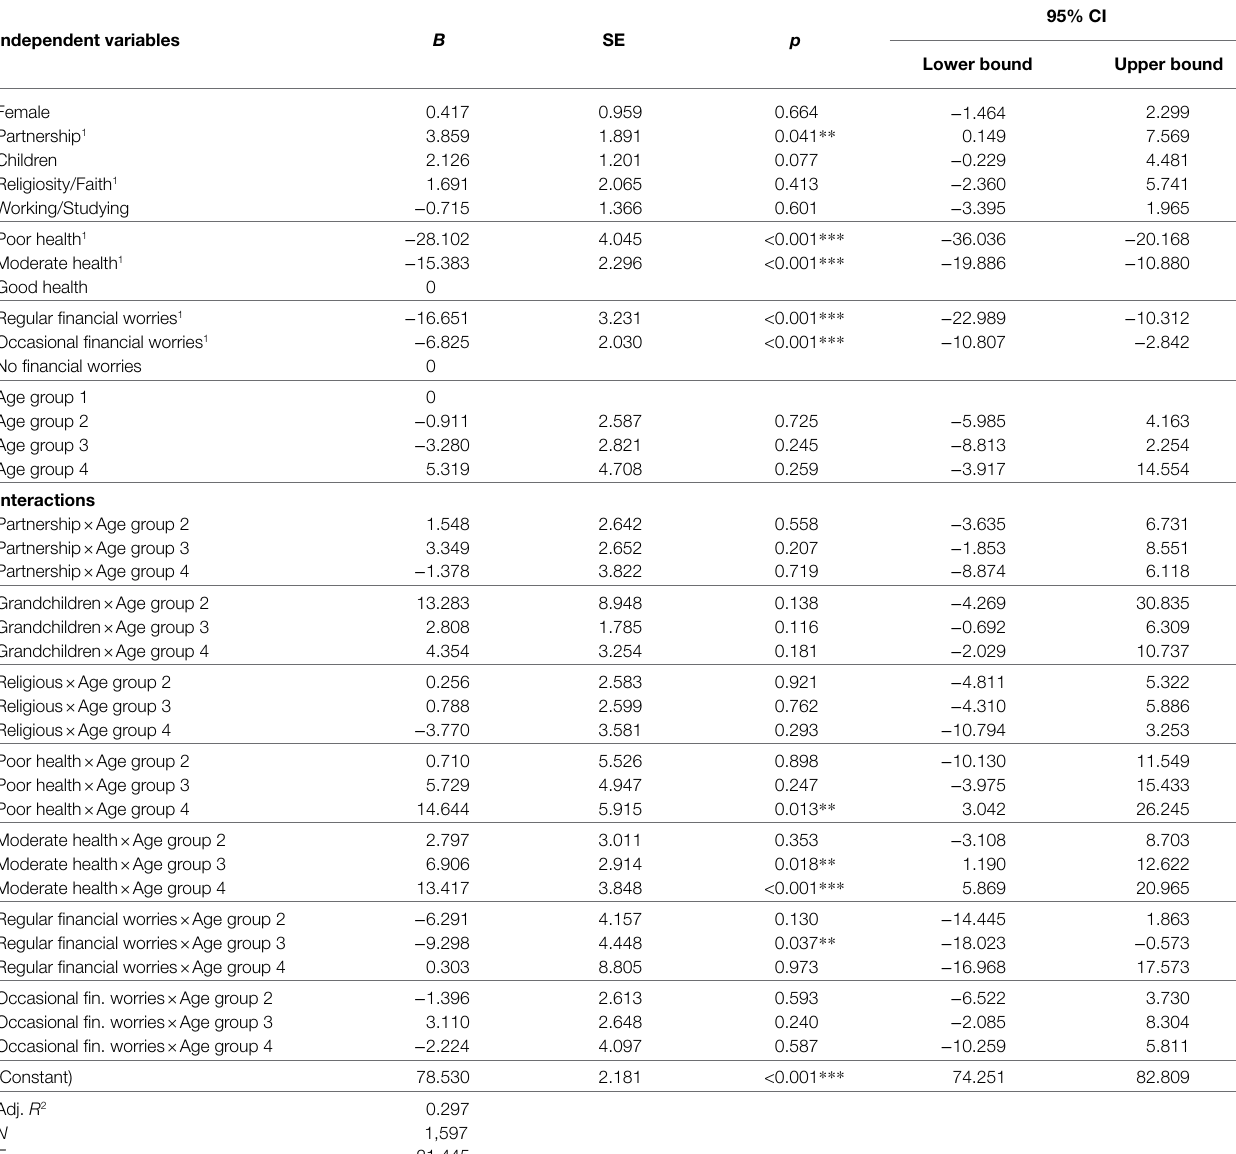
TABLE 5 | Regression of satisfaction by demographic variables and interactions of age groups with demographic variables.